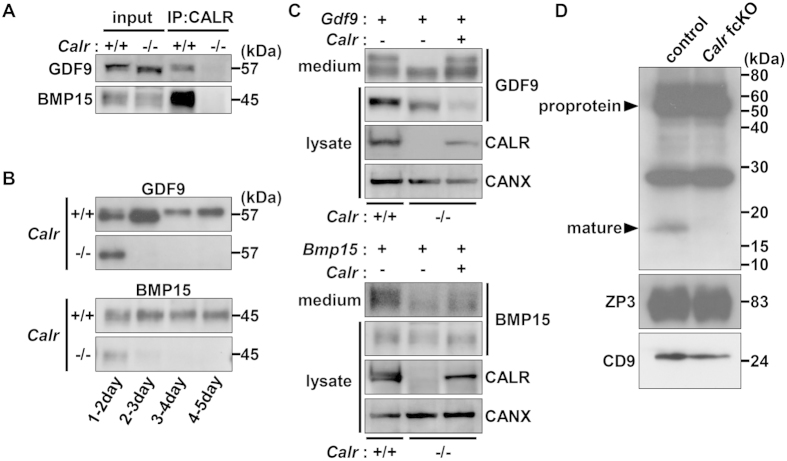
CALR is essential for extracellular secretion of GDF9 and BMP15.(A) Calr+/+ or Calr−/− MEFs expressing Flag/His tagged GDF9 or BMP15 were immunoprecipitated (IP) with anti-CALR antibody from the cell lysates (50 μg) and the immunoprecipitates were probed with anti-His antibody on immunoblots. (B) Secreted GDF9 and BMP15 from Calr+/+ or Calr−/− MEFs were examined every 24 hours after transfection. Calr−/− MEFs stopped secreting these proteins after 1–2 days. (C) Secreted GDF9 and BMP15 were both observed as a single band in Calr−/− MEFs. The upper band was recovered by co-transfection with a plasmid expressing Calr. (D) The 57 kDa GDF9 proprotein was present, but not the 17.5 kDa mature GDF9 in CALR deficient oocytes. Other glycoproteins, CD9 and ZP3, were normally expressed. 300 oocytes (GDF9) or 20 oocytes (ZP3 and CD9) were loaded per lane.